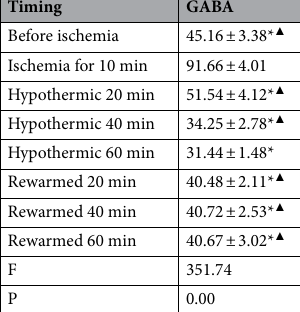
Table 5. Changes in GABA content in brain extracellular fluid (μmol/L) ( x ± s, n = 9). *Compared with ischemia for 10 min, *P < 0.05. ▲ Compared with rewarmed 60 min, ▲ P < 0.05.